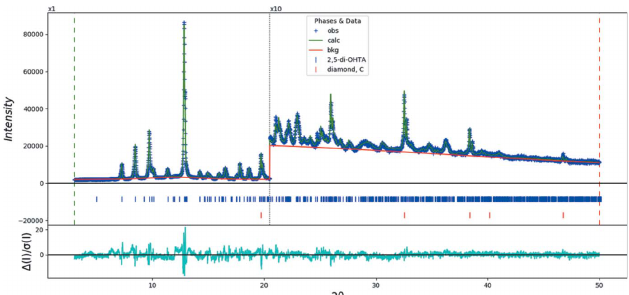
Figure 7 The Rietveld plot for the refinement of anhydrous 2,5-dihydroxy- terephthalic acid. The blue crosses represent the observed data points, and the green line is the calculated pattern. The cyan curve is the normalized error plot, and the red line is the background curve. The row of tick marks indicates the calculated reflection positions. The vertical scale has been multiplied by a factor of 10 (cid:6) for 2 (cid:3) > 20.5 (cid:5) . The row of red tick marks indicate the positions of the diamond internal standard